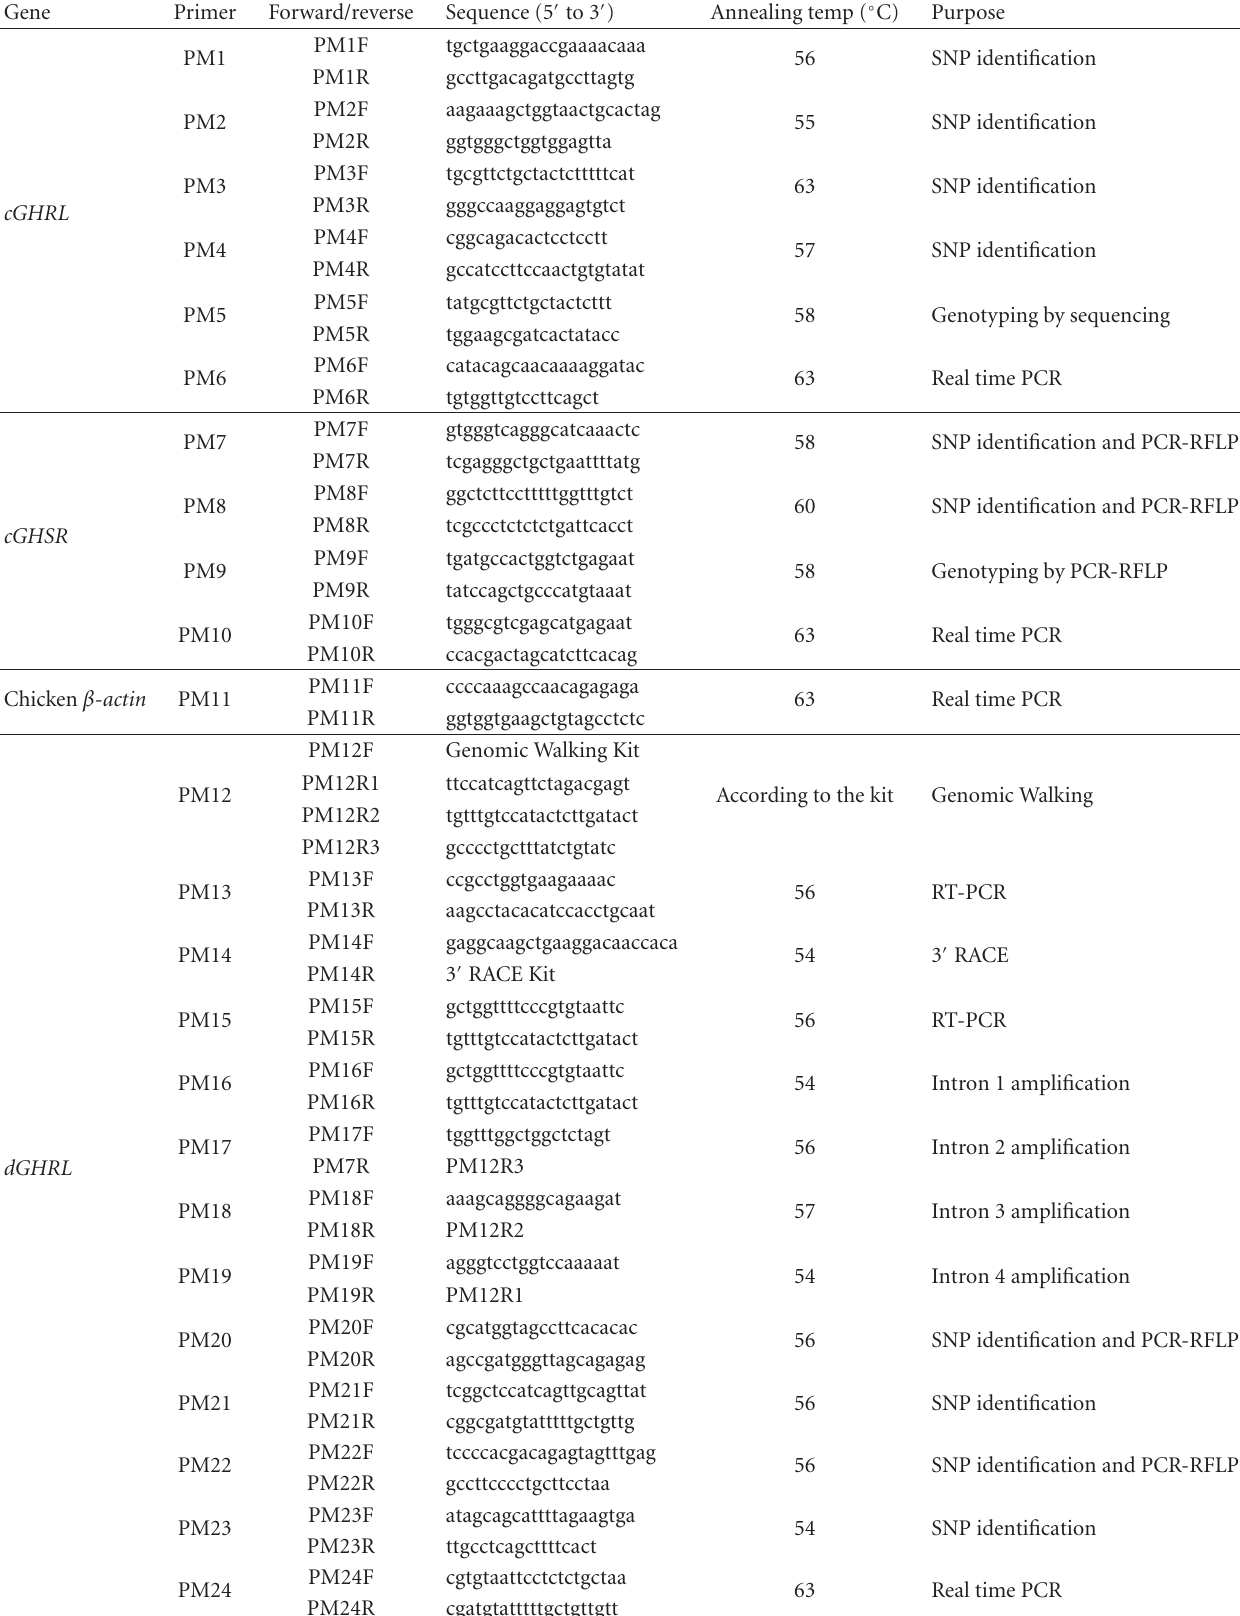
Table 2: Descriptions of the 33 primers used in this